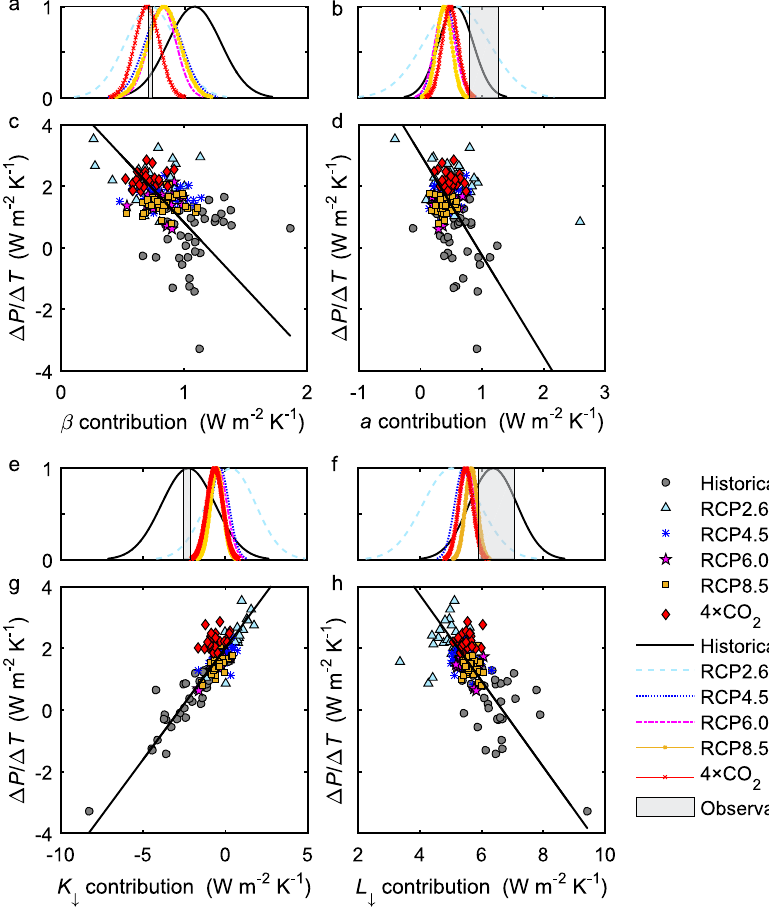
Fig. 3 Relationship between global precipitation temperature sensitivity and temperature sensitivity of surface energy balance components. c , d , g , h Relationship between precipitation temperature sensitivity ( Δ P / Δ T ) and contribution from change in Bowen ratio β [ − ( R n − G )/(1 + β ) 2 /( Δ β / Δ T )], surface albedo a [ − K ↓ /(1 + β )( Δ α / Δ T )], surface downward shortwave radiation K ↓ [(1 − α )/(1 + β )( Δ K ↓ / Δ T )] and surface downward longwave radiation L ↓ [1/(1 + β )( Δ L ↓ / Δ T )]. a , b , e , f Gaussian probability distribution of the component contribution. The observational range (mean ± one standard deviation) is denoted by the gray bar. Solid lines are regression fi t. Other variables are R n ocean surface net radiation, G ocean heat storage. Description of model scenarios is given in Fig. 1